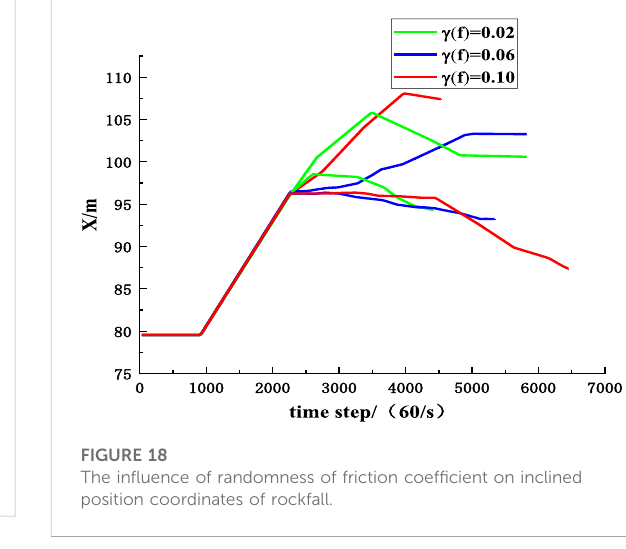
FIGURE 16 The offset ratio of rockfall